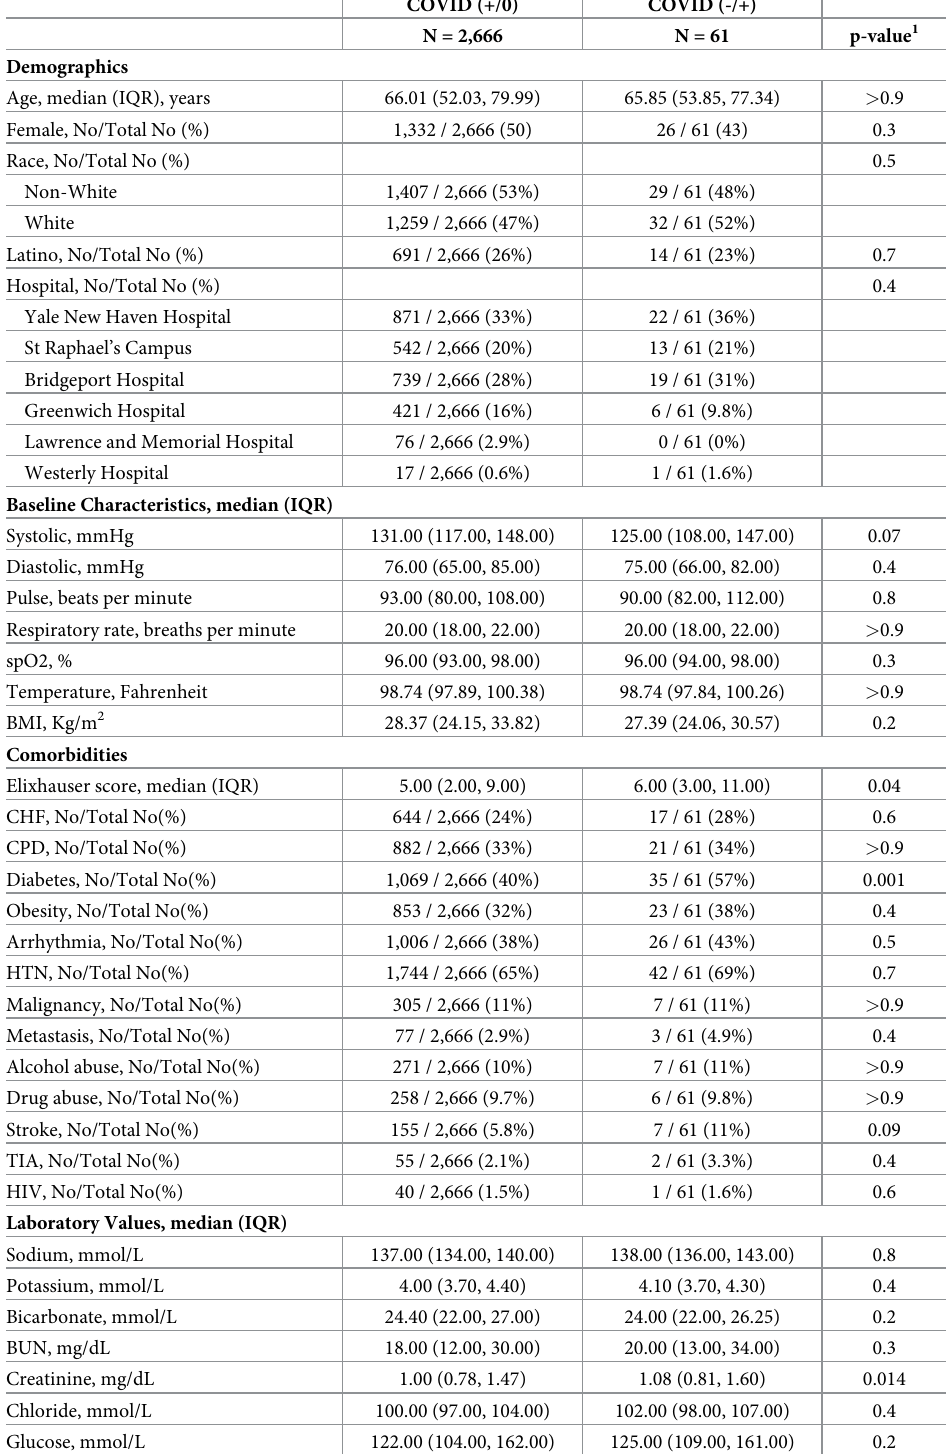
Table 1. Characteristics of patients with COVID positive test on admission vs. those who tested negative on admission and had a subsequent COVID positive